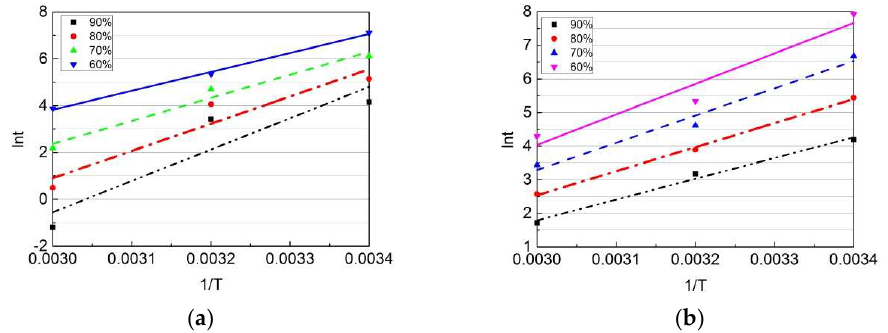
Figure 17. Arrhenius graphs based on the first prediction model: ( a ) G1; ( b ) G2.